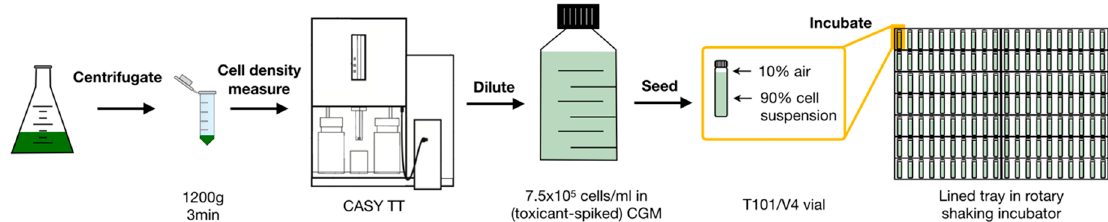
Figure 9. Individual steps for centrifugal concentration, cell density measurement, dilution, seeding of C. reinhardtii cell cultures into T101 / V4 vials, and incubation of vials on a lined tray. Biological replicates in vials ( n = 4 per experimental group) were generated from independent flask cultures.